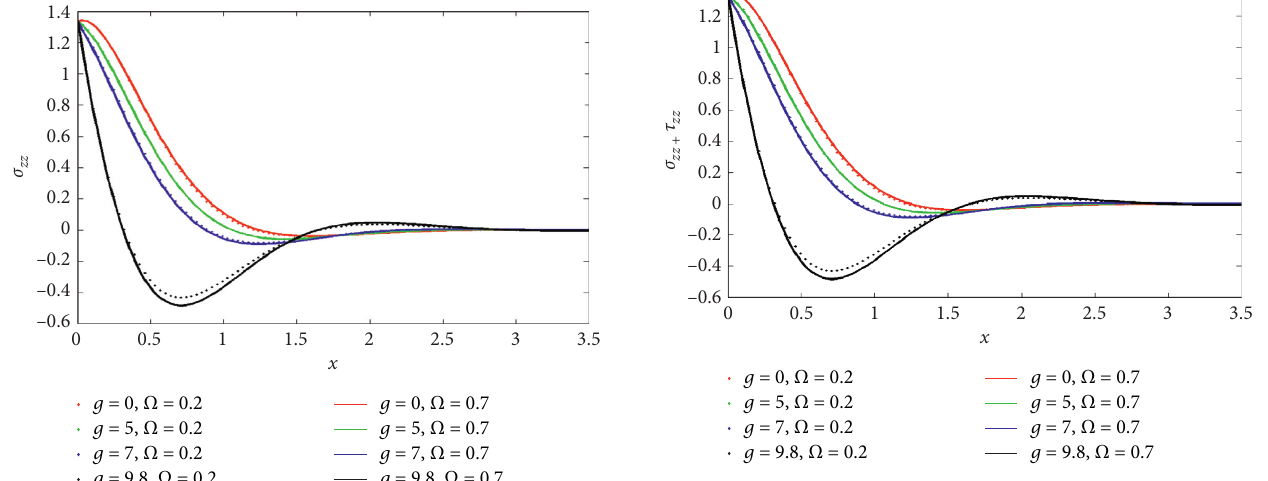
x under gravity and rotation.